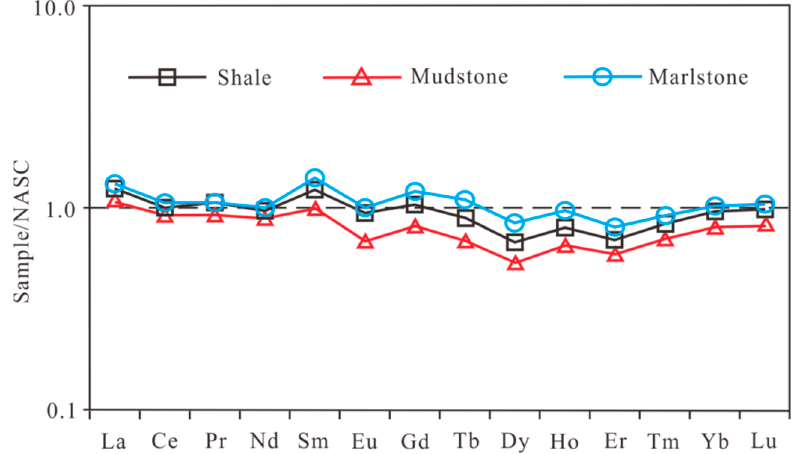
Figure 6. NASC-normalized REE distribution patterns for three different lithologies.